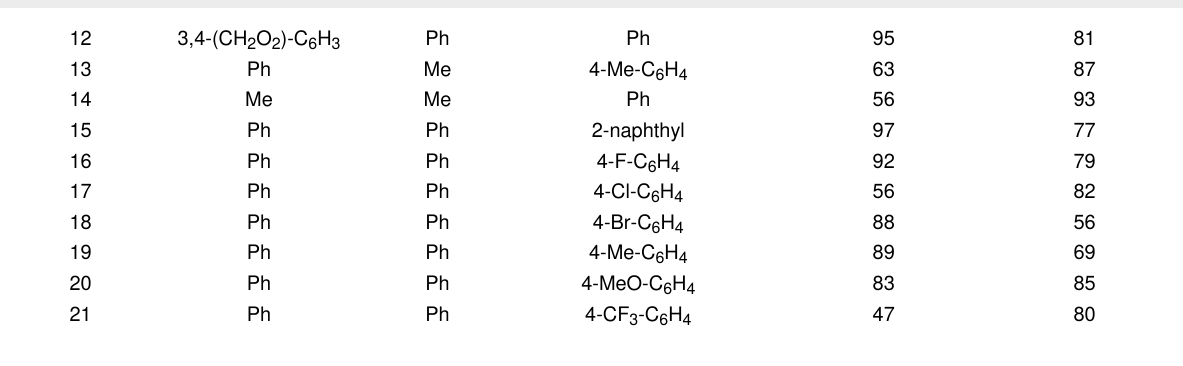
Table 12: Application of dimeric palladacycle PdL6 in the addition reactions of arylboronic acids to various enones [43]. (continued)